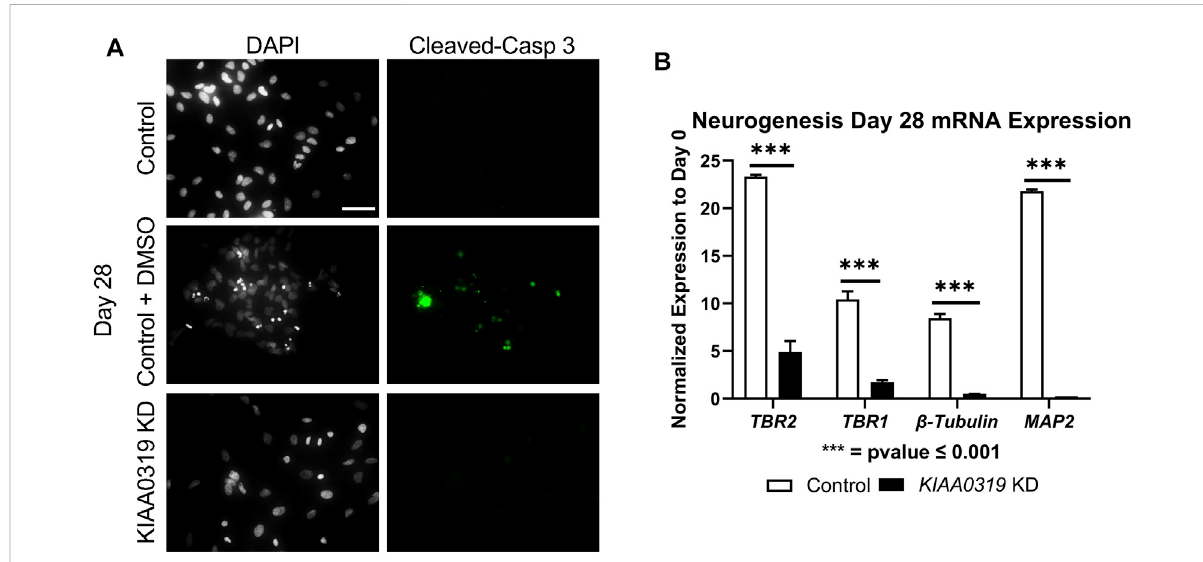
FIGURE 4 KIAA0319 KD cells do not continue differentiating. (A) Images of KIAA0319 KD, Control, Control + DMSO (Positive Apoptosis Control) at day 28 of neuronal differentiation stained with cleaved-caspase 3 (green) and DAPI (grey). (B) QRT-PCR at day 28 for neuronal lineage markers TBR1, TBR2, β -Tubulin, and MAP2.